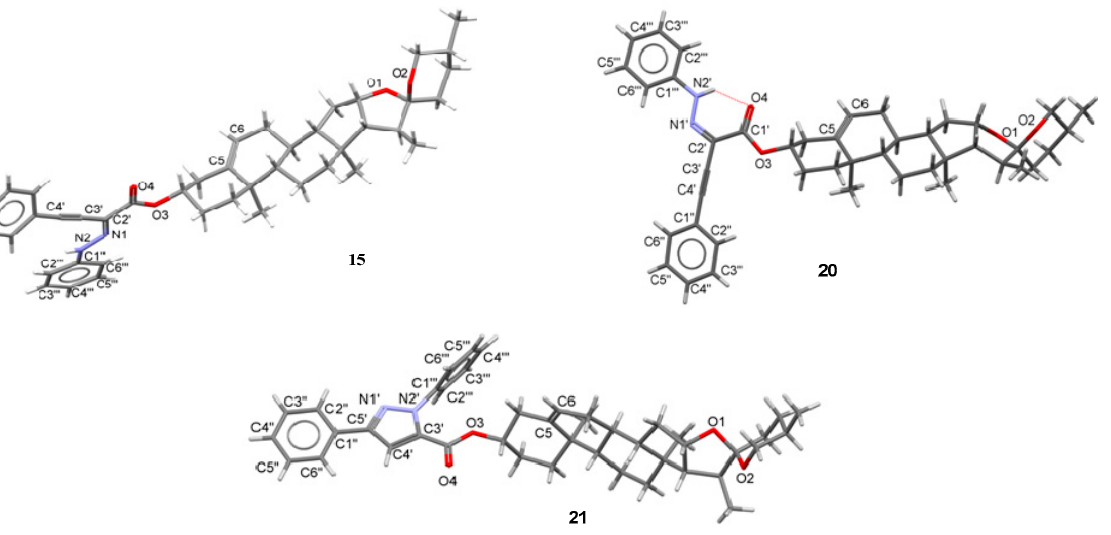
Figure 3. Molecular structures of isomeric hydrazones 15 , 20 and steroidal pyrazole 21 . The thermal ellipsoids are drawn at the 30% probability level.